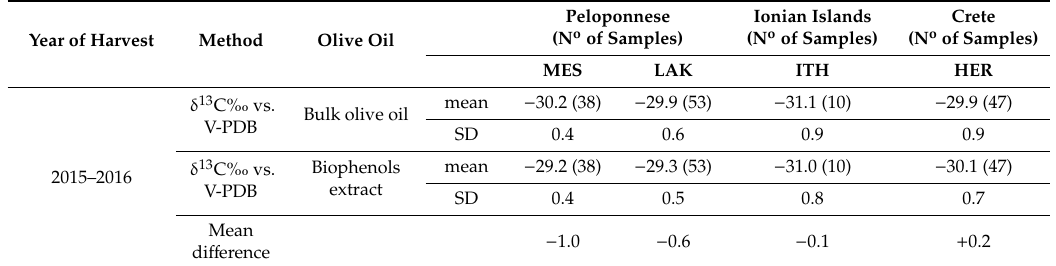
Table 4. The mean δ 13 C VPDB isotopic values of whole Greek olive oils and their biophenolic